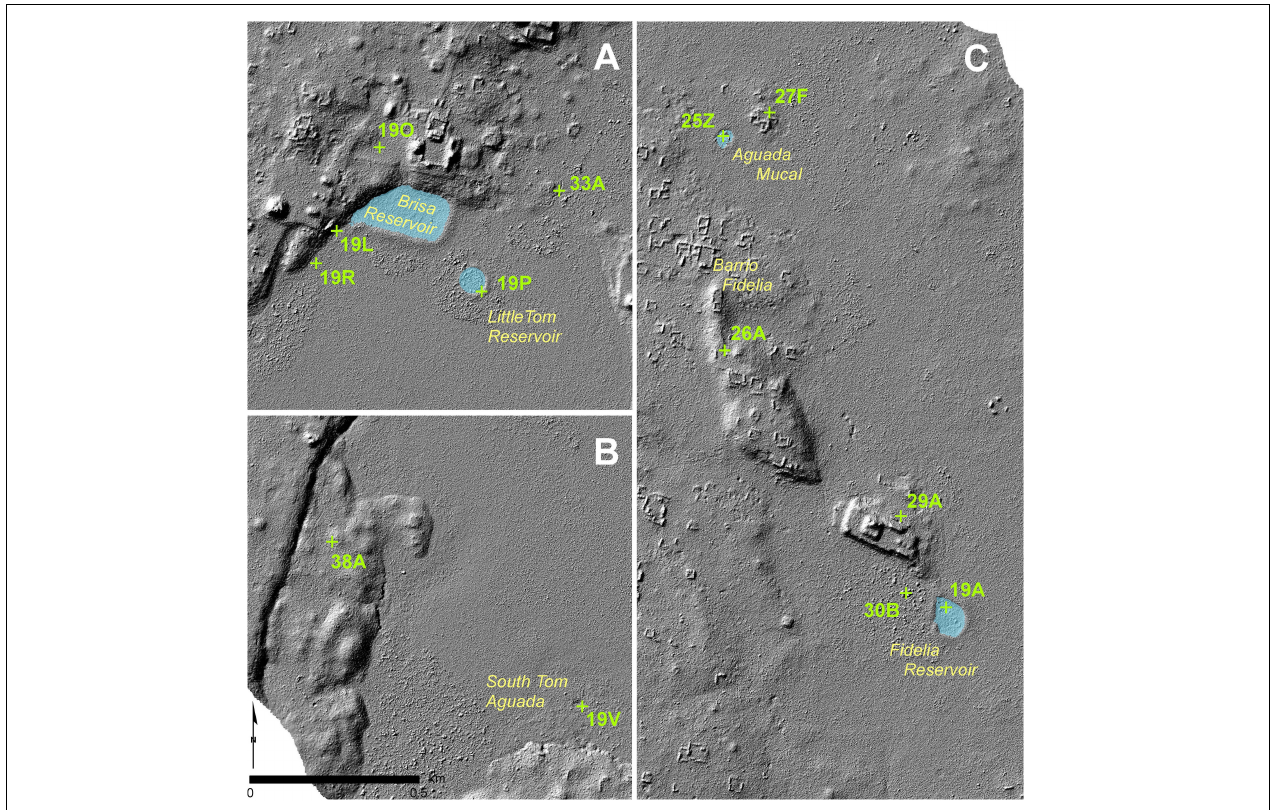
FIGURE 3 | Close-up lidar images of: (A) the Brisa reservoir, (B) the South Tom aguada, and (C) the Fidelia reservoir.